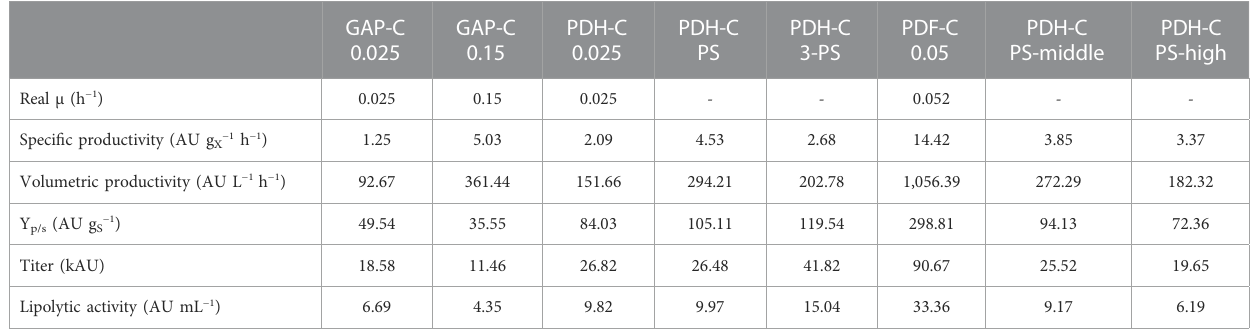
TABLE 2 Comparison of key performance indicators of PDH-C standard and optimized fed-batch cultivations with the benchmarks GAP-C and PDF-C fed-batch cultivations. All the parameters are calculated from the feeding phase.